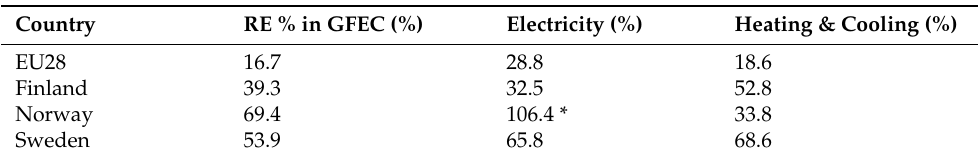
Table 1. Shares of renewable energy in the gross final energy consumption (GFEC) and in the electricity and the heating and cooling sectors in 2015